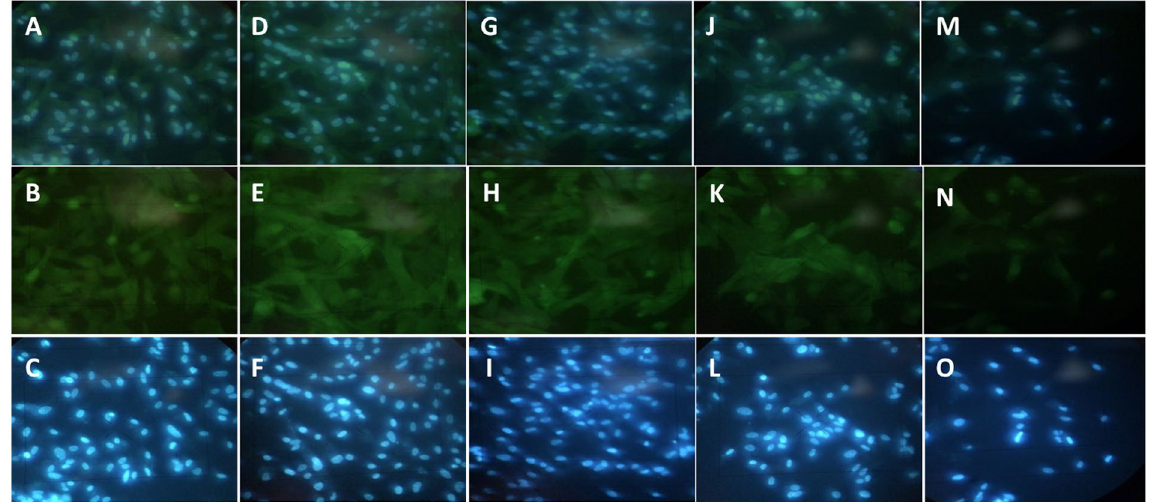
Figure 11. Phalloidin stained stem cells on day 7 after cultured on the surface of plasma treated substrate. (B: P = 10 (W), R = 3; E: P = 20 (W), R = 2; H: 20 (W), R = 1; K: P = 20 (W), R = 2; N: control), stained by DAPI: C: :P = 10 (W), R = 3; F: P = 20 (W), R = 2; I: 20 (W), R = 1; O: control) and Phalloidin and DAPI merged.